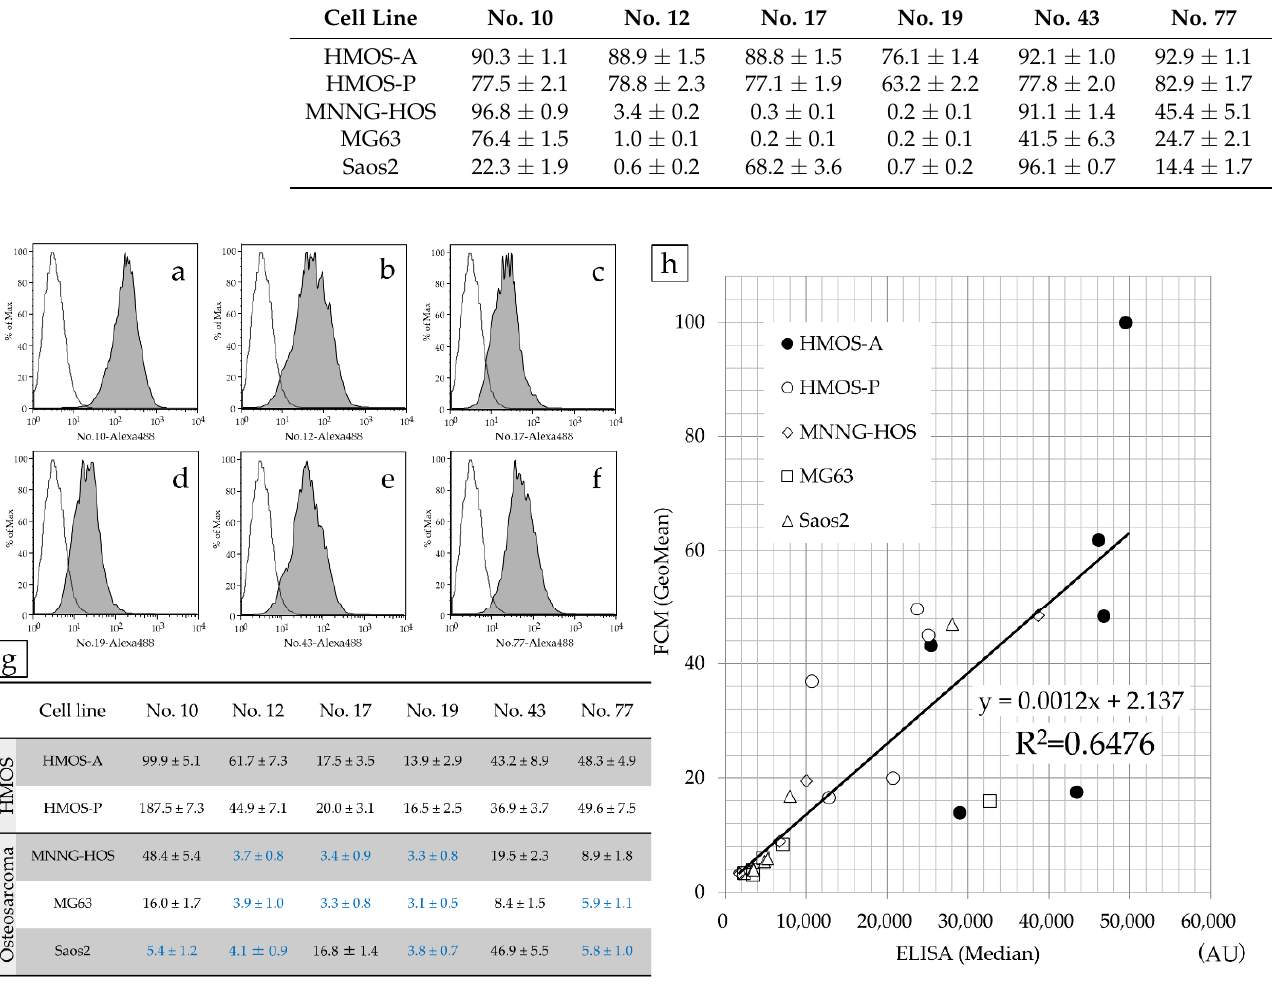
Figure 3. Correlation between ELISA-based and FCM fluorescence intensities at HMOS-P. FCM histograms of antibody numbers 10 ( a ), 12 ( b ), 17 ( c ), 19 ( d ), 43 ( e ), and 77 ( f ) incubated with HMOS-P. The FCM fluorescence intensity (GeoMean) for all cell lines was investigated. According to the results of flow cytometry of the HOS cell lines, most antibodies against antibody numbers 12, 17, 19, and 77 were negative (the values highlighted in blue were judged to be negative). In the HMOS cell line, most cells of antibody numbers 12, 43, and 77 were positive ( g ). The correlation between ELISA fluorescence intensity (median) and FCM fluorescence intensity (GeoMean) for all cell lines was strong. The correlation coefficient was r = 0.805 ( h ).